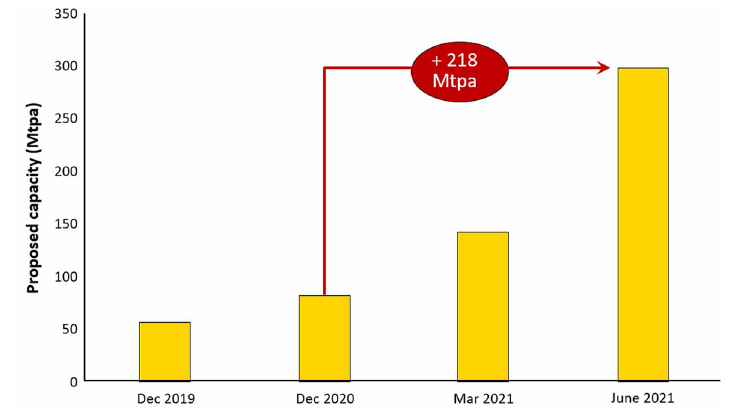
Fig. 5. – Total proposed CO 2 storage capacity in CCS projects [1].